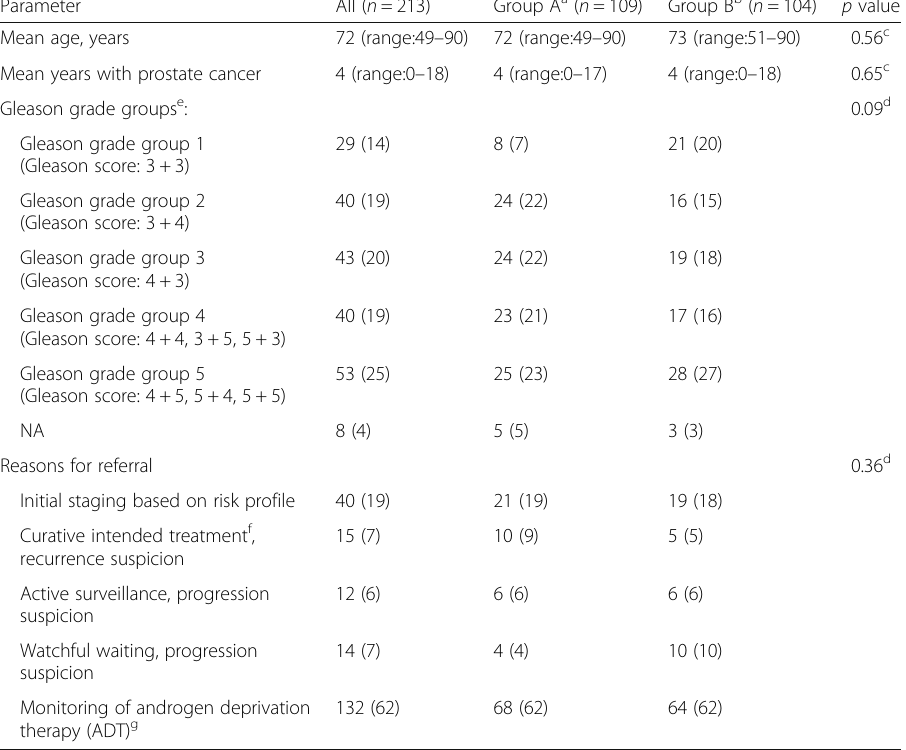
Table 1 Characteristics of participants